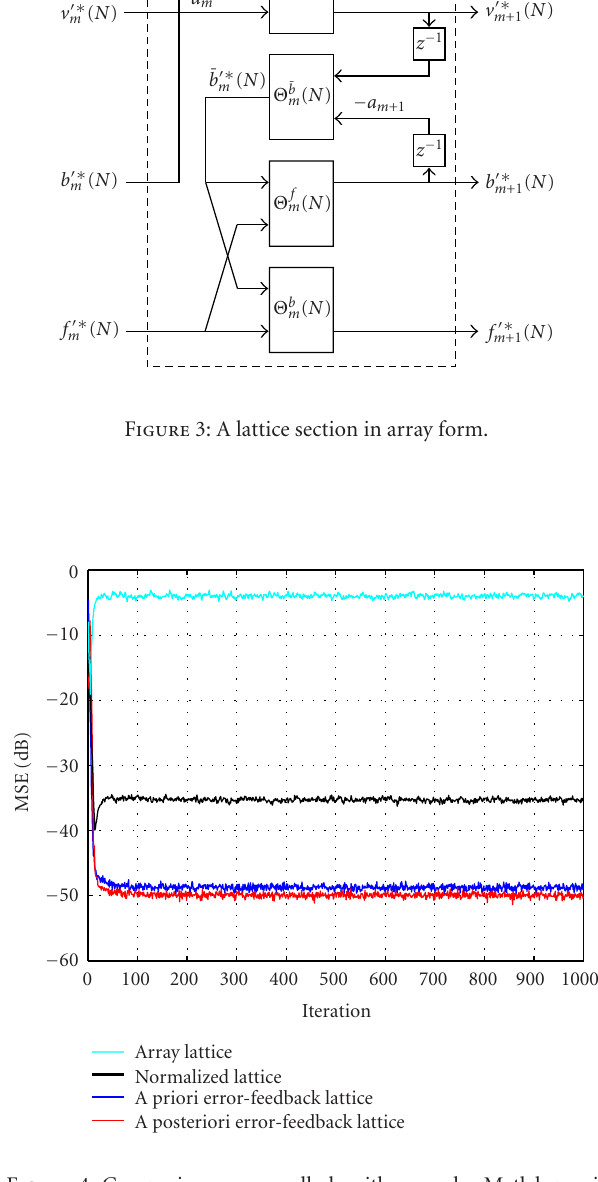
Figure 4: Comparison among all algorithms under Matlab preci- sion.